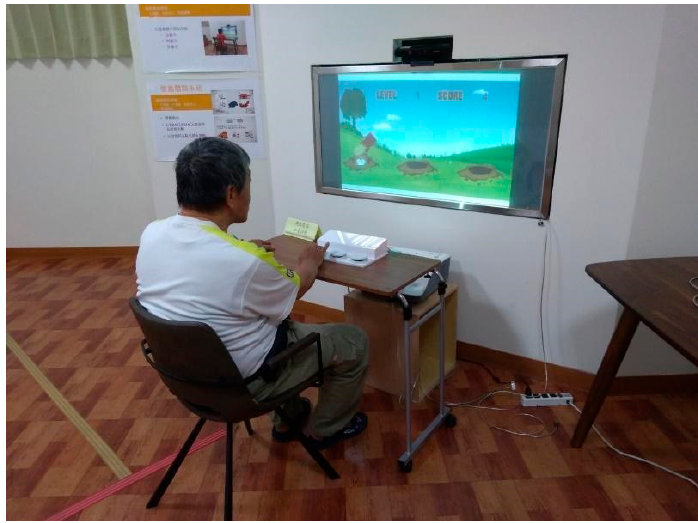
Figure 4. A subject playing a PC serious game in our experimental room using a designed board-button.